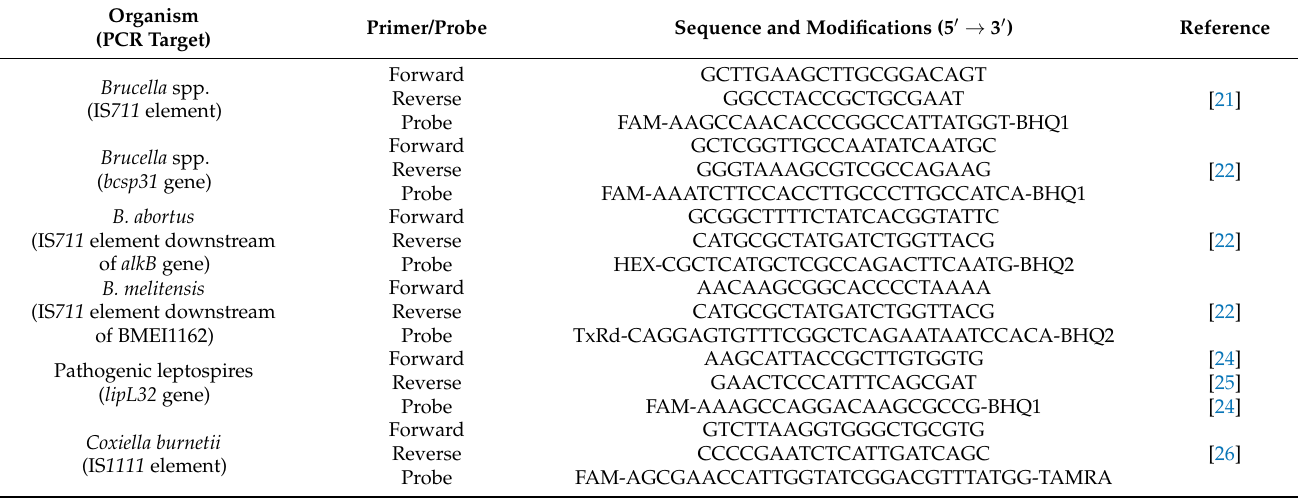
Table 1. A summary of the primers and probes used to detect Brucella spp., pathogenic leptospires, and C. burnetii